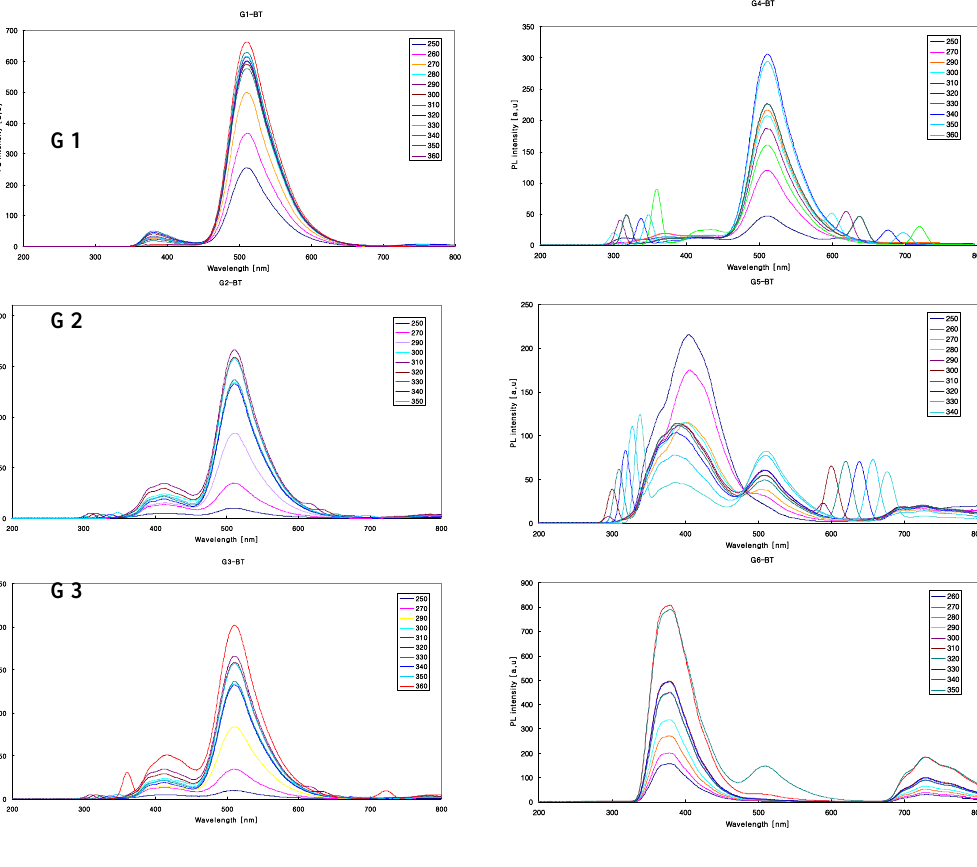
Scheme 3. Position of benzothiazole on dendritic